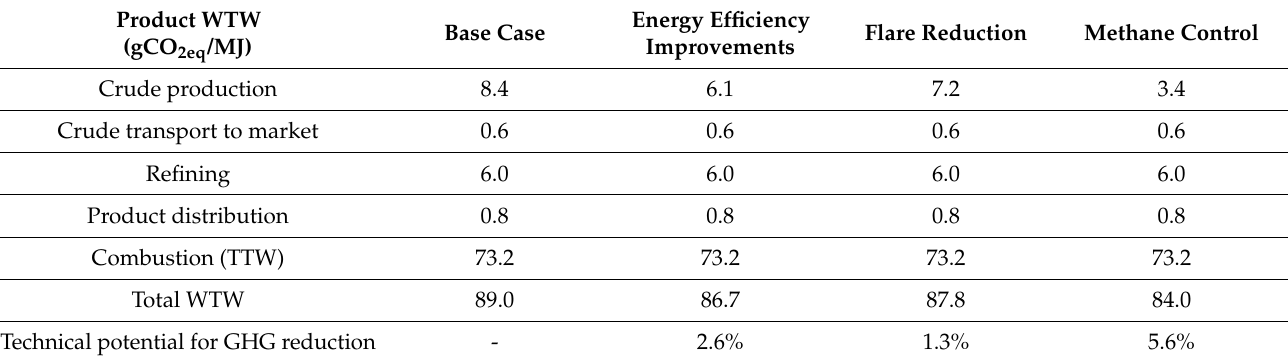
Table 4. Summary of the technical potential of upstream GHG emission reduction